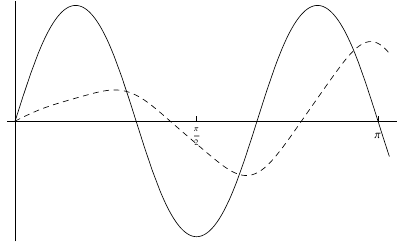
Figure 4. The solution of the problem x (cid:48)(cid:48) = − 12 x + x 3 , x (0) = x ( π ) = 0 together with the solution y ( t ) (dashed) of the respective equation of